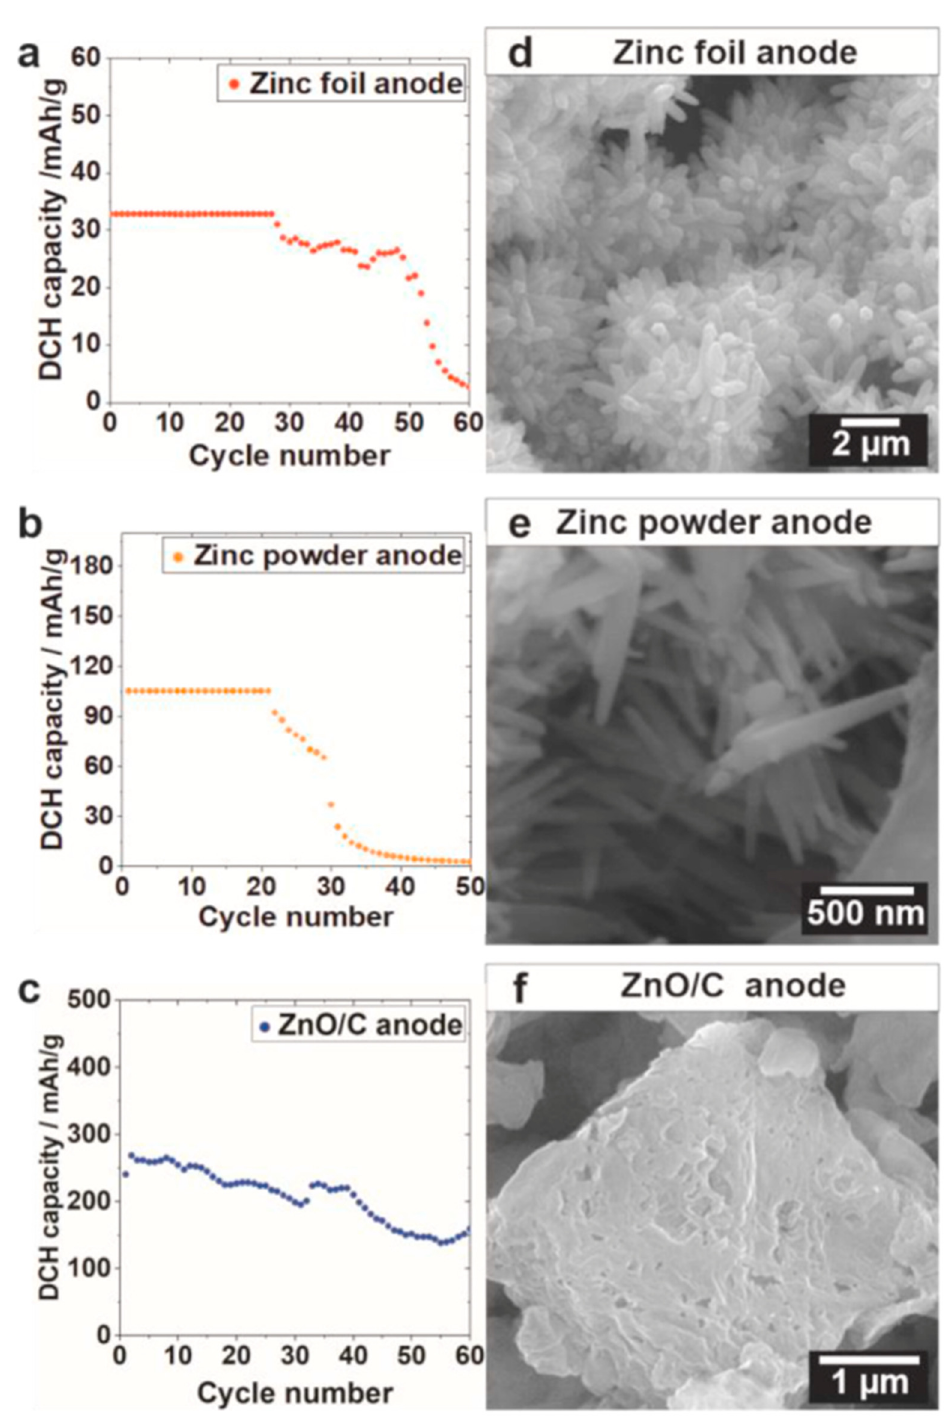
Figure 4. Galvanostatic cycling of zinc anode with different morphology; ( a , b ) the zinc foil anode displayed steady cycling (27 cycles) with 32 mAh/g of discharge capacity and zinc powder exhibits 105 mAh/g of discharge capacity for 21 cycles. ( c ) ZnO/C composite anode exhibits maximum discharge capacity of 267 mAh/g because of enhanced zinc availability. The SEM image of ZnO/C confirms no dendrite formation ( f ), whereas zinc foil and zinc powder anodes displayed voluminous dendrite generation and electrode destruction ( d , e ) [17]. Reprinted with permission from Ref. [17], Copyright 2021, Elsevier.